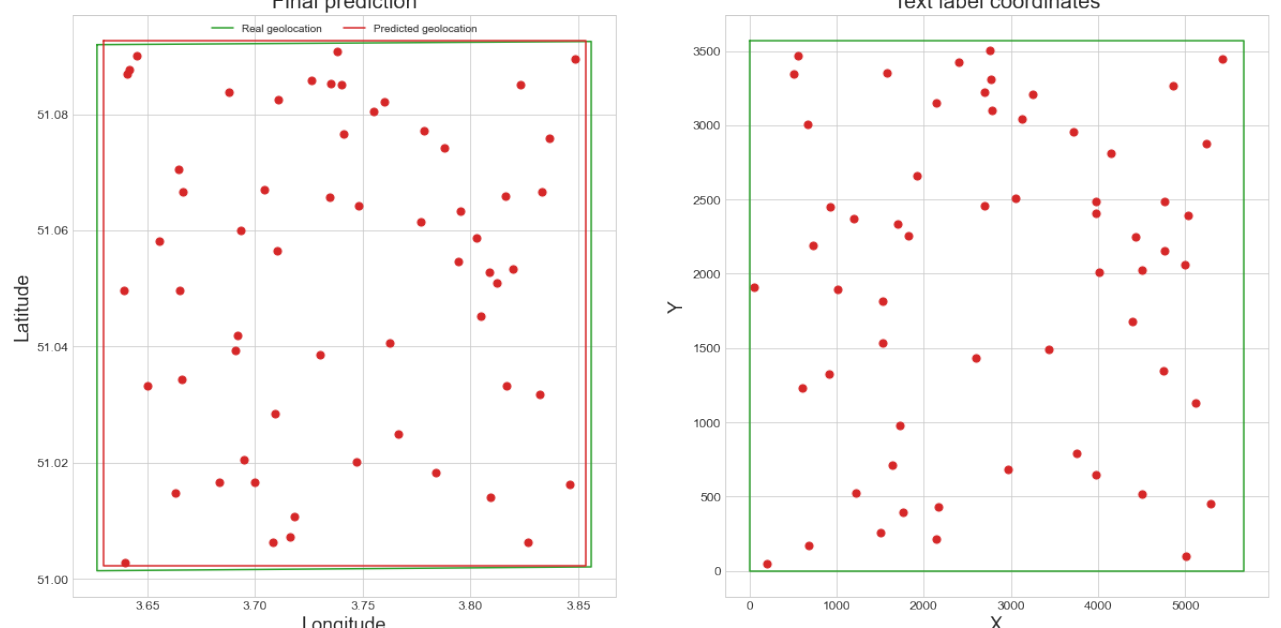
Figure 10. Final geolocation prediction (in red) and ground truth geolocation (in green) for the map of Gent-Melle. Point pairs used for the prediction are marked in red. There is a visible correlation between the relative positions of the point